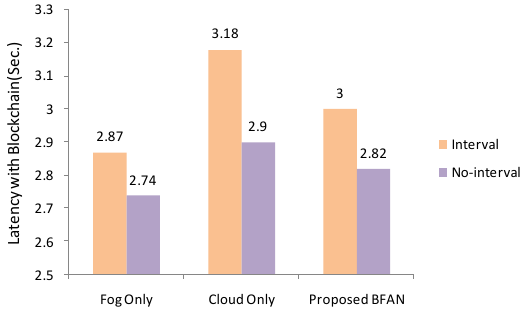
Figure 8. Latency comparison of proposed BFAN with fog and cloud